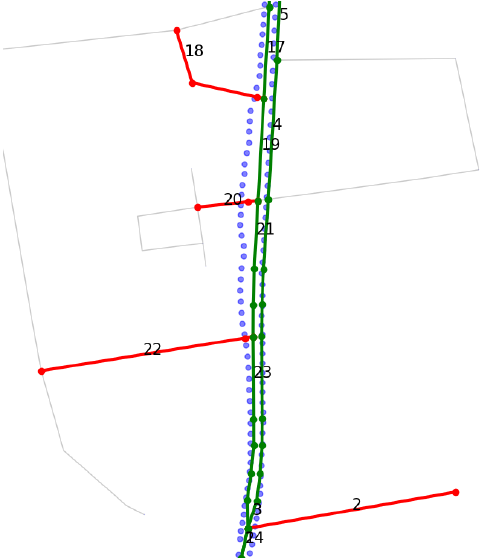
Figure 9. Model outcome for Cat-I error : identified hanging segments in Dataset 26.